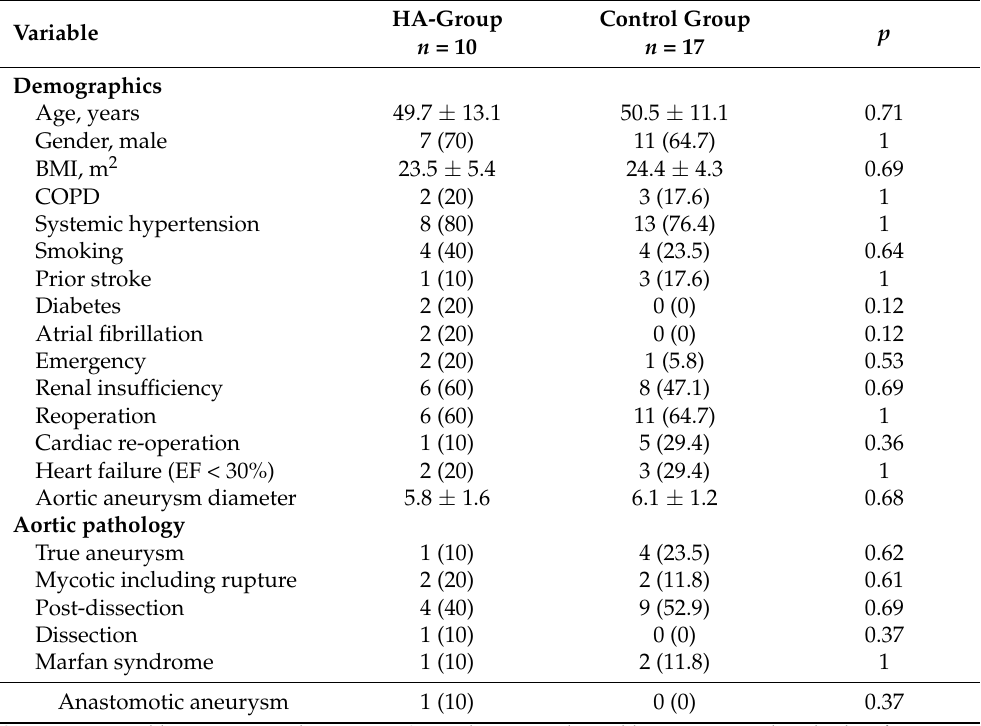
Table 1. Baseline